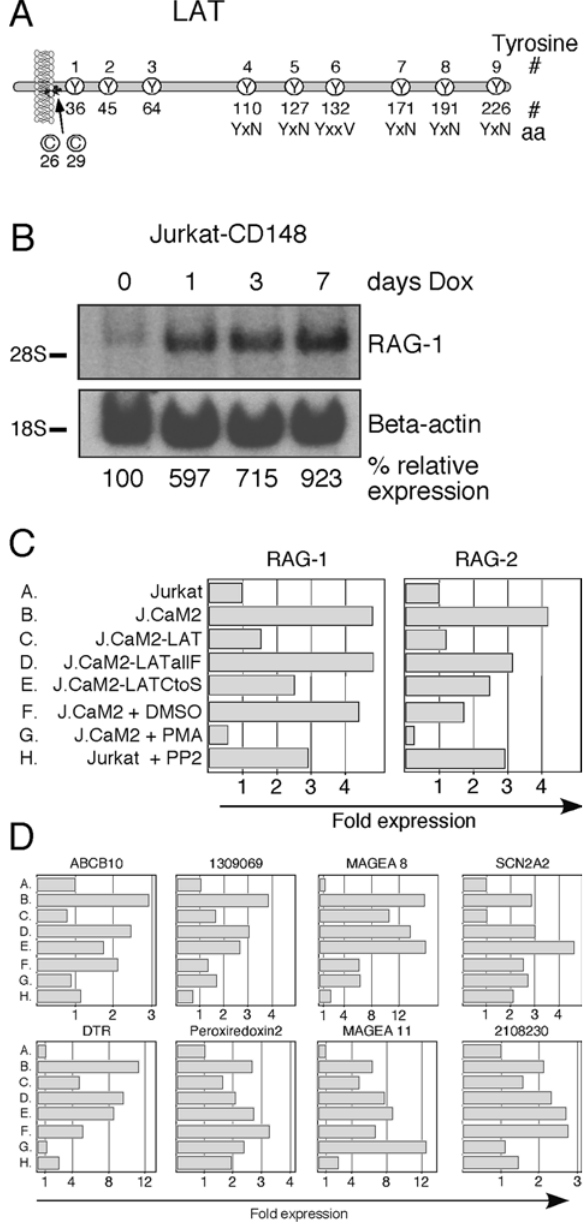
Figure 3. Proper Expression of RAG-1 and RAG-2 Requires a Signaling- Competent LAT Molecule (A) Graphic representation of human LAT. Conserved tyrosine residues in mammals are numbered 1 through 9, with the corresponding amino acid numbering below. Cysteine residues 26 and 29 are required for palmitoylation. Adapted from Lin and Weiss (2001). (B) RAG-1 expression by Northern blotting in Jurkat T cells induced to express the phosphatase CD148 for increasing periods of time. (C) RAG-1 and RAG-2 expression by DNA array analysis. Expression of the two genes was set at 1 in wild-type Jurkat cells and compared to expression in J.CaM2 cells, in J.CaM2 reconstituted with wild-type LAT (J.CaM2-LAT), or with signaling-mutant LAT molecules (J.CaM2- LATallF and J.CaM2-LATCtoS). In addition, expression profiles were compared to J.CaM2 treated with DMSO, J.CaM2 stimulated with PMA (25 ng/ml for 24 h), and Jurkat cells incubated with PP2 (20 l M for 24 h). (D) Expression profiles of genes with increased expression in J.CaM2 and a similar expression behavior as RAG-1 and RAG-2 . Abbrevia- tions: ABCB10, ATP-binding cassette, subfamily B, member 10;